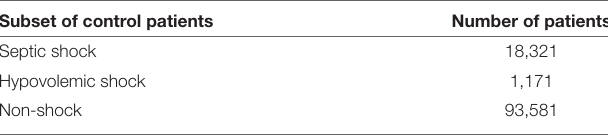
TABLE 3 | Patients with septic shock, hypovolemic shock, and no shock in the control patient group.